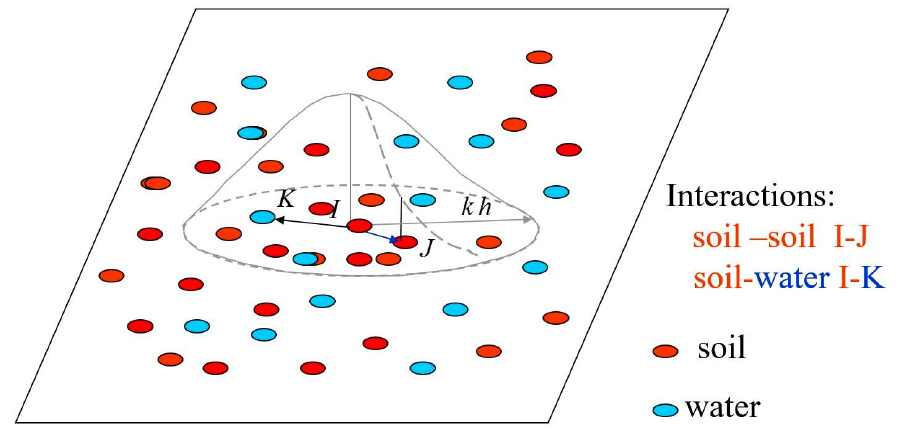
Figure 2. SPH interactions for two-phase